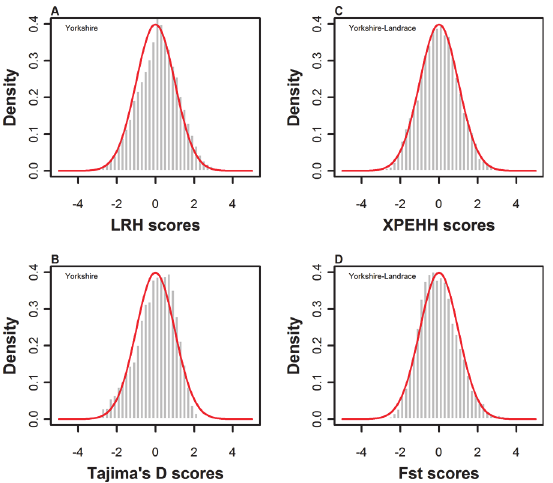
Figure 1. Empirical distribution of four test statistics in Yorkshire and breed pair of Yorkshire-